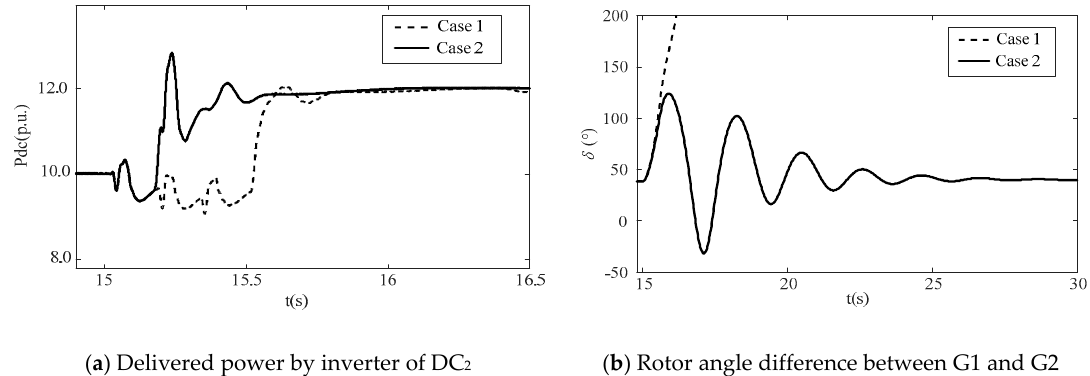
Figure 9. Control effect under different control method.